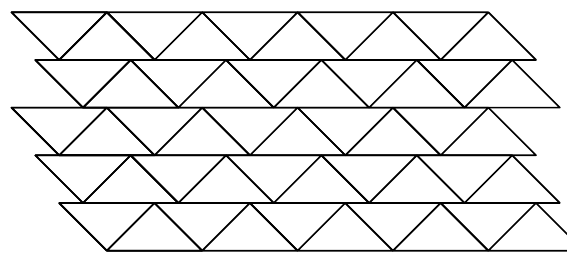
Fig. 60: Tiling with isosceles triangles (NC).